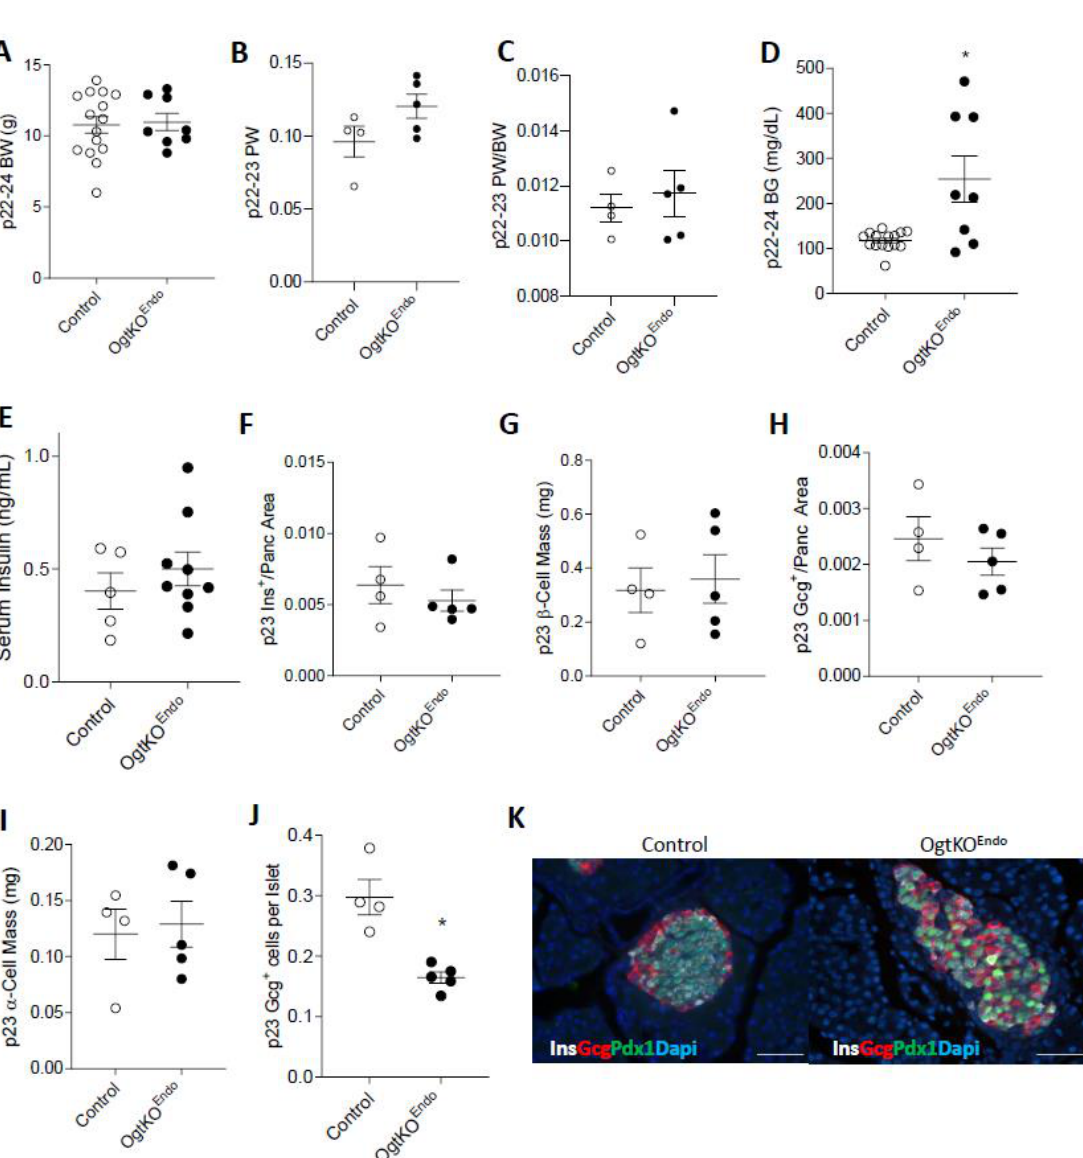
Figure 3. Disregulated islet architecture in male p23 OgtKO Endo mice. At p23: Bodyweight ( A , n = 8–15), pancreas weight ( B , n = 4–6), and pancreas weight corrected over bodyweight ( C , n = 4–5). Elevated non-fasting blood glucose ( D , n = 8–15, * p = 0.0151) in OgtKO Endo . Serum insulin levels from non-hyperglycemic (BG < 150 mg/dL) OgtKO Endo ( E . n = 5–9). Quantification of Insulin + /Pancreas area ( F , n = 4–5), β -cell mass ( G , n = 4–5), Glucagon + /Pancreas area ( H , n = 4–5), α -cell mass ( I , n = 4–5), and Glucagon + cells/islet ( J , n = 4–5, * p = 0.0159, quantified over total number of Ins + , Gcg + , and Ins + /Gcg + cells). Representative images of the islet showing α -cell invasion to the islet core in OgtKO Endo ( K , 40 × , scale = 50 µ m). Statistics were performed with a Mann–Whitney U-Test (two-tailed with significance p ≤ 0.05). In all graphs, open circle = Control and closed circle = OgtKO Endo . Female data in Supplementary